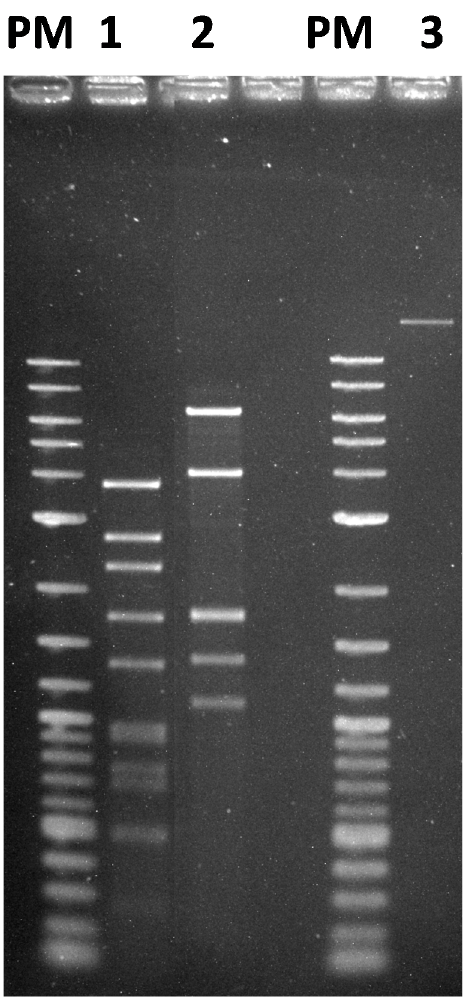
Figure 3. Restriction enzyme patterns of phage GC1 DNA. Lane 1, Eco RI; lane 2, Eco RV, lane 3, undigested DNA. PM, 2-Log DNA ladder (Biolabs, Ipswich, MA, USA).